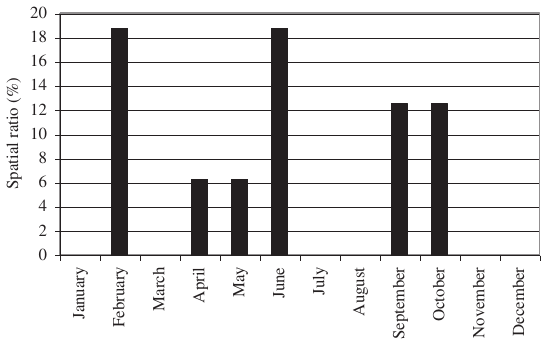
Figure 15 – The spatial ratio and monthly distribution of signifi cant (95%) changes of absolute daily maxima of precipitation according to Table 2 – Slopes of the linear function in seasonal distribution expressing temporal changes of the absolute daily maxima of precipitation raised on data of 16 stations over the period of 60 years 1951–2010 ABS. MAX. PREC.